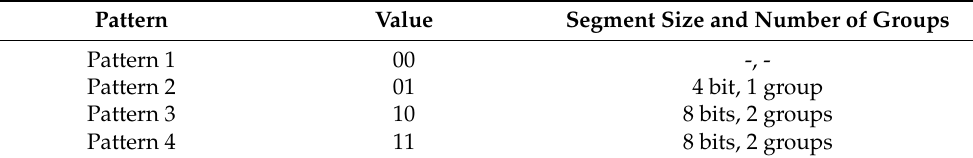
Figure 2. Operand sequence compression coding format. Table 1. Four different patterns.